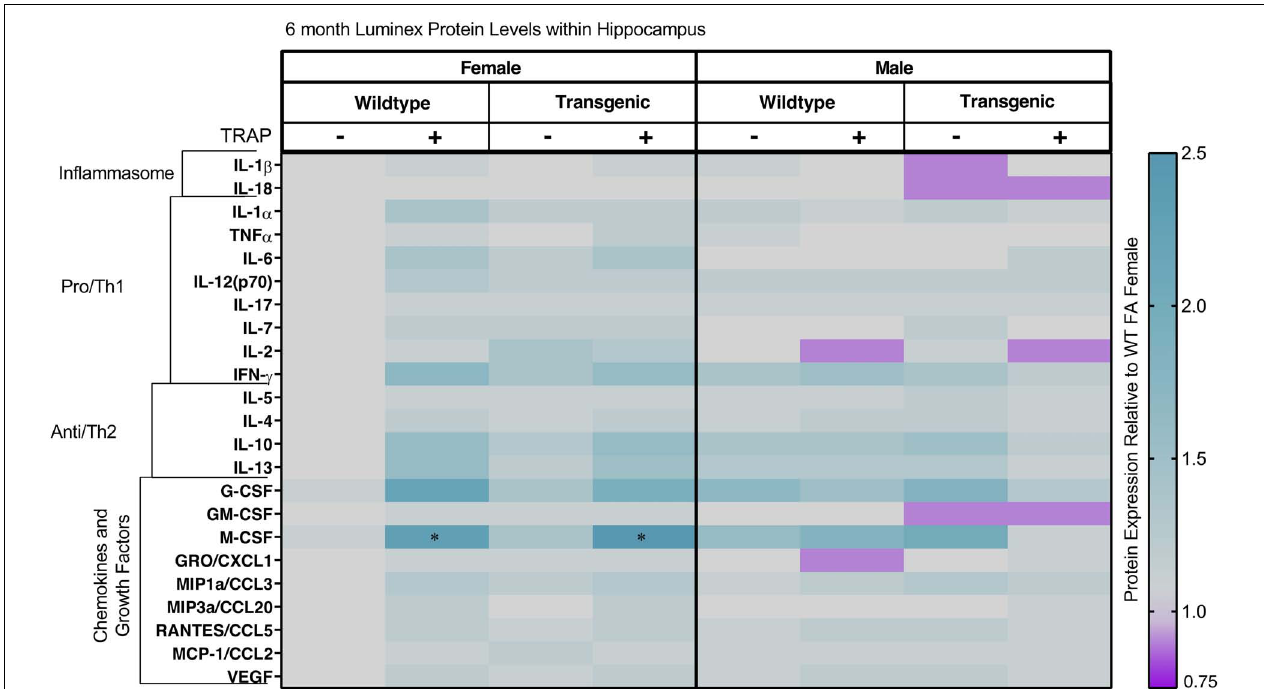
FIGURE 7 | Heat map representation of hippocampal cytokine, chemokine, and growth factor changes in response to TRAP in 6-month old TgF344-AD and WT rats. Hippocampal levels of cytokines and growth factors in TgF344-AD and WT rats exposed to FA or TRAP for 5 months were analyzed using multiplex technology. For each analyte, individual values were normalized to the mean level of that same analyte in hippocampal tissue from female FA WT animals. Purple indicates normalized protein levels < 1.0; turquoise indicates normalized protein levels > 1.0. ± indicates exposure with + identifying TRAP-exposed animals; - indicating FA-exposed animals; n = 4–5 animals per group (duplicate samples were analyzed for each animal). ∗ Significantly different from sex-matched WT FA control at p < 0.05 as determined by post hoc Sidak’s test. Non-normalized cytokine values for female WT animals are provided in Supplementary Table 2